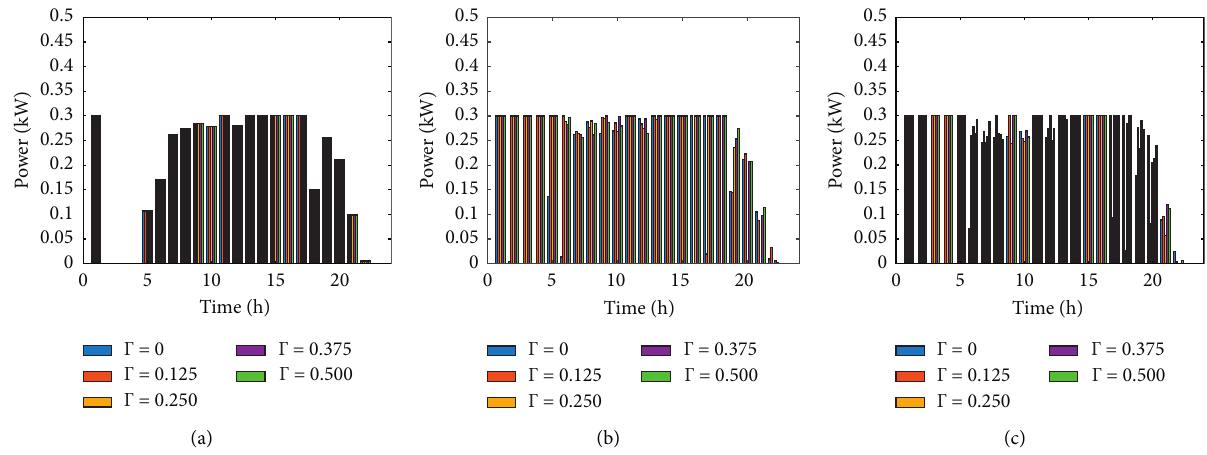
Figure 5: Comparison of the load shedding between the RMPC method and the traditional MPC. (a) WI1 � 0.0. (b) WI2 � 2.5%. (c) WI3 �